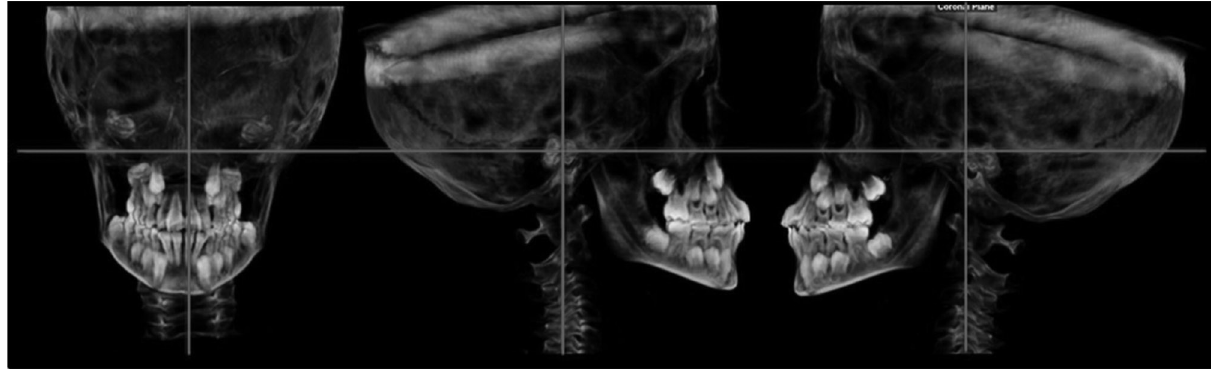
Figure 1. Cranial positioning orientation using Software Dolphin 3D ® (Dolphin Imaging/Patterson Dental, Chatsworth,